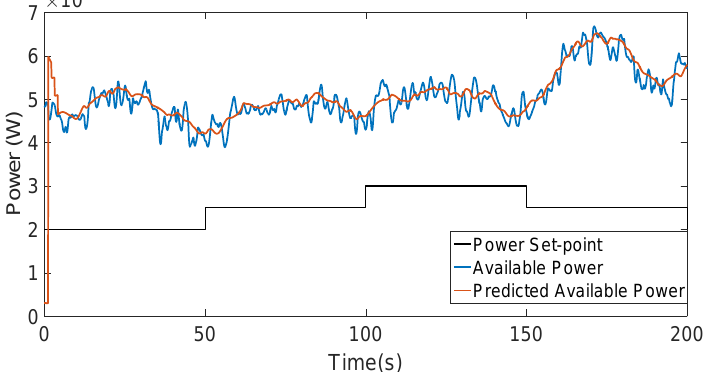
Figure 6. Set-point and available power for the tested wind farm.